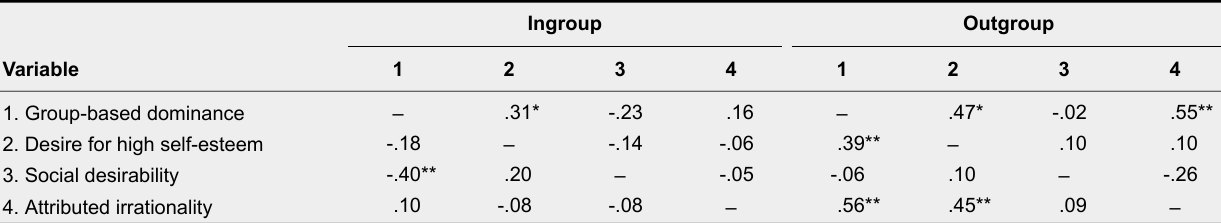
Zero-Order Correlations With Pearson’s r for Study 3, Separately for Two Methods of Presenting the Target Person(s) and Their